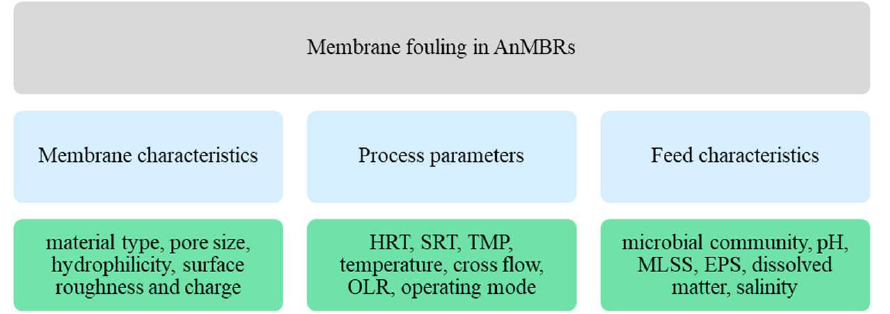
Figure 4. The factors affecting fouling in MBRs. HRT—hydraulic retention time, SRT—solid retention time, TMP—transmembrane pressure, OLR—organic loading rate, MLSS—mixed liquor suspended solid, EPS—extracellular polymeric substance.